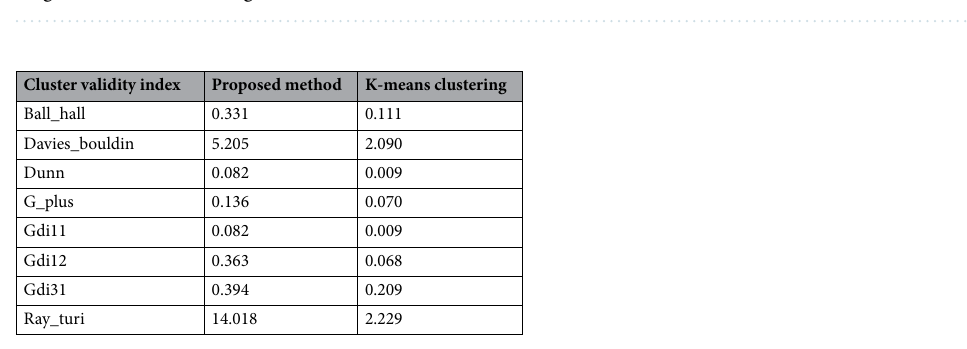
Table 2. Comparison of various cluster validity indices between our proposed method and k-means clustering for AD vs control. Higher value signifies better than the other value in the same row (cluster validity index).